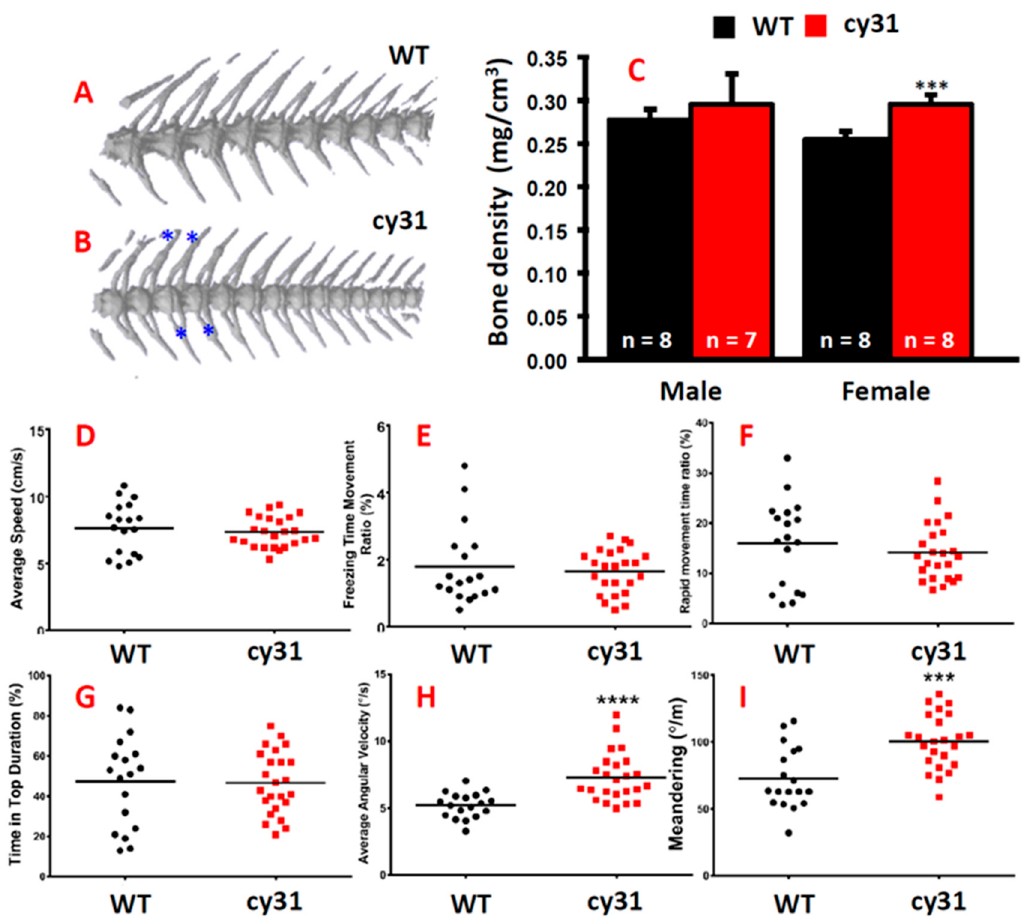
Figure 6. Computed tomography of both genders in wild type and Tg(Ola.Sp7:N1aICD) cy31 fish. ( A , B ) Three dimensional computed tomography for female WT, female Tg(Ola.Sp7:N1aICD) cy31 , male WT, and male Tg(Ola.Sp7:N1aICD) cy31 fish. Three-dimensional computed tomography of spinal bone for WT and Tg(Ola.Sp7:N1aICD) cy31 fish. The blue * indicated the region where the knots occured (n = fish number). ( C ) Bone density of WT and N1aICD-overexpressing transgenic fish in both genders. ( D – I ) Comparison of three-dimensional locomotion swimming patterns between WT and Tg(Ola.Sp7:N1aICD) cy31 transgenic fish which are based on endpoints of average speed ( D ), freezing time movement ratio ( E ), rapid movement time ratio ( F ), time in tope duration ( G ), average angular velocity ( H ), and meandering ( I ). Significance was tested by Student’s t -test and data were presented as averages ± SD (*** p < 0.005, **** p < 0.001). Black circles and red squares represent the data for wild type and Tg(Ola.Sp7:N1aICD) cy31 fish, respectively.